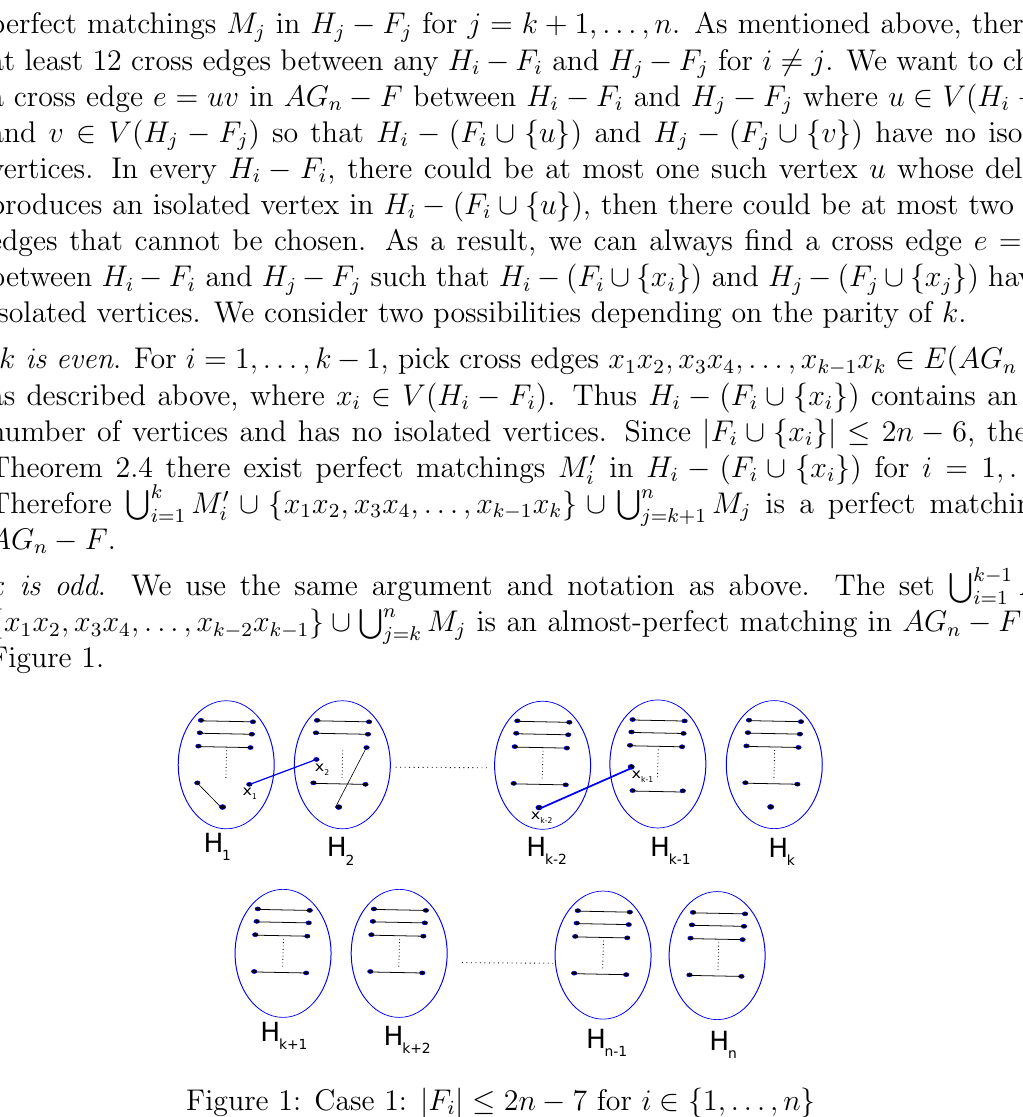
Figure 1: Case 1: | F